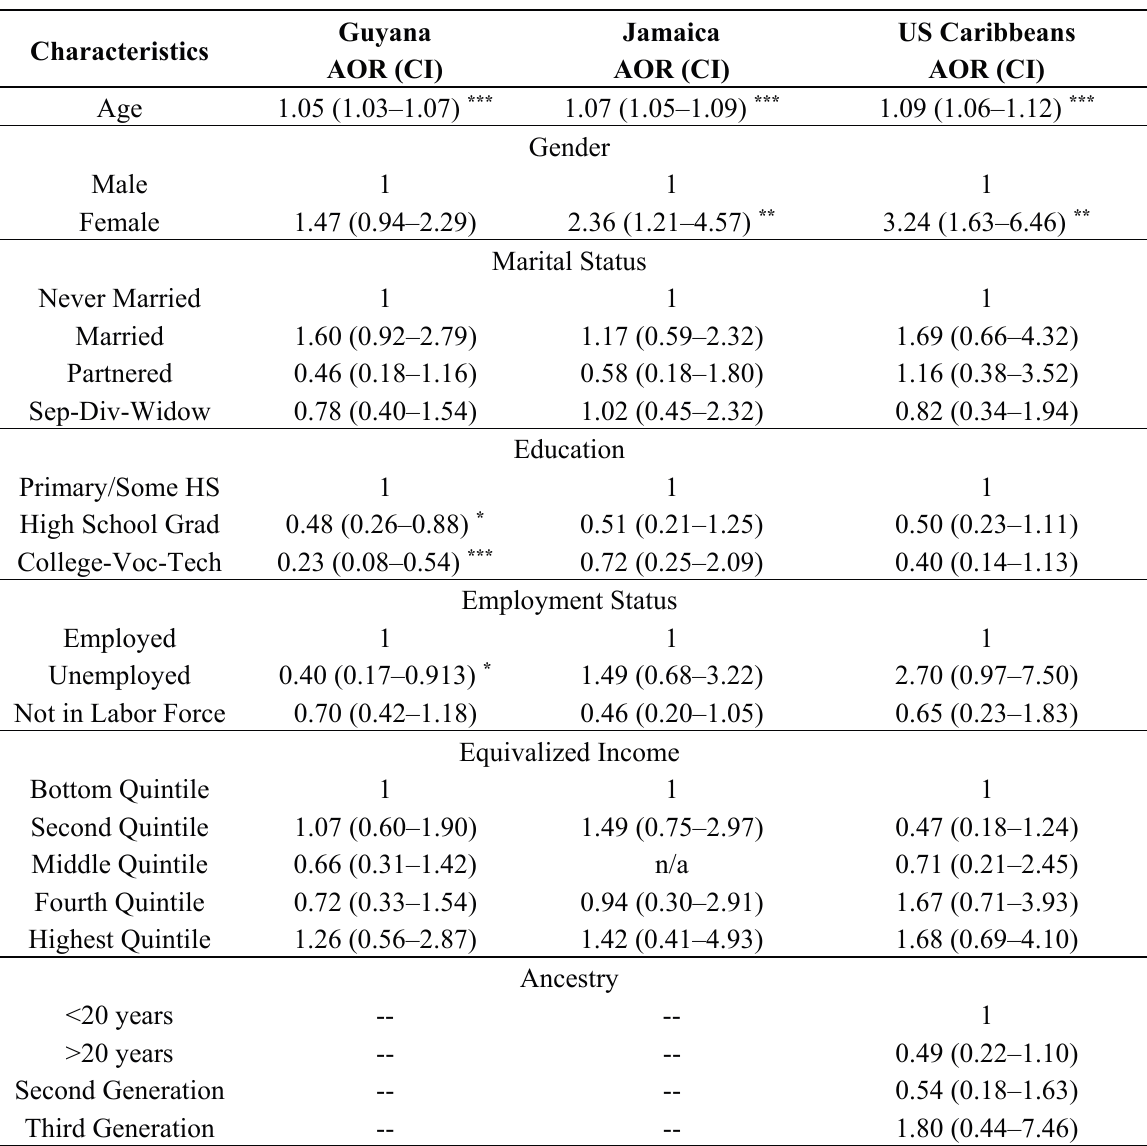
Table 7. Factors associated with lifetime prevalence of diabetes by